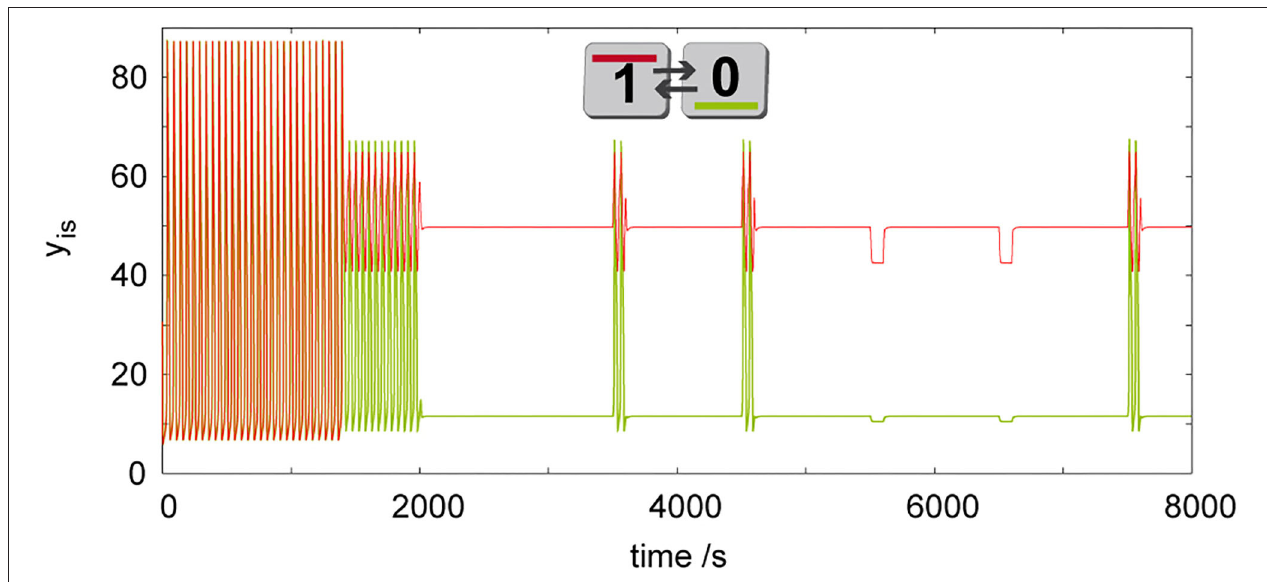
FIGURE 6 | Simulation of dynamic behavior of two cells ( q = 1, σ M = 100 s − 1 , σ inh = 35 s − 1 , k ADP = 0.1 s − 1 ) working as a tautology/contradiction gate, where discrete Turing pattern is forced by a long time perturbation ( 1 T = 600s, A i = 1.2) of only a single cell. To show robustness of the discrete Turing pattern, system is further perturbed in the first cell by perturbations A i = 1.2 at t k = {3,500, 4,500, 7,500} s and by A i = − 0.5 at t k = {5,500, 6,500} s using 1 T = 100s. The only pattern in this figure is shown by its symbolic representation followed by digital 0/1 output assignment.